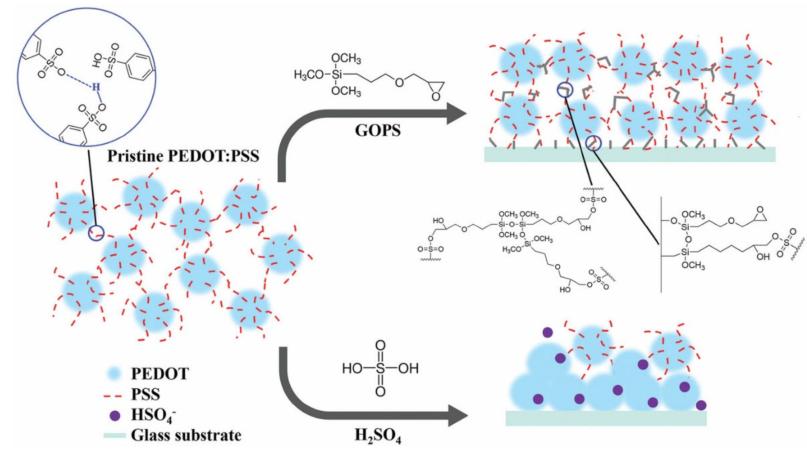
Figure 2. Schematic diagram of proposed PEDOT:PSS molecular structure changes via crosslinker addition and acid post-treatment. Reproduced from [111] with permission from John Wiley and